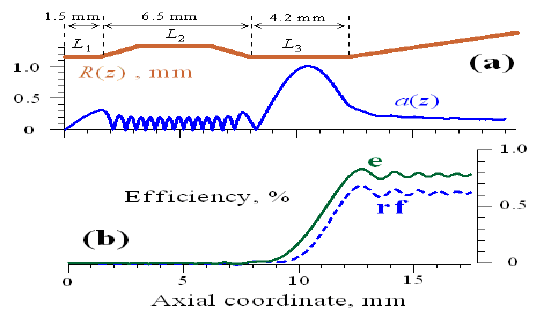
Fig. 1. (a): Sectioned cavity of the third-harmonic large- orbit gyrotron. (b): Results of simulation of the operation at a frequency of 0.74 THz; electron efficiency (e) and rf wave efficiency (rf) versus the axial coordinate.